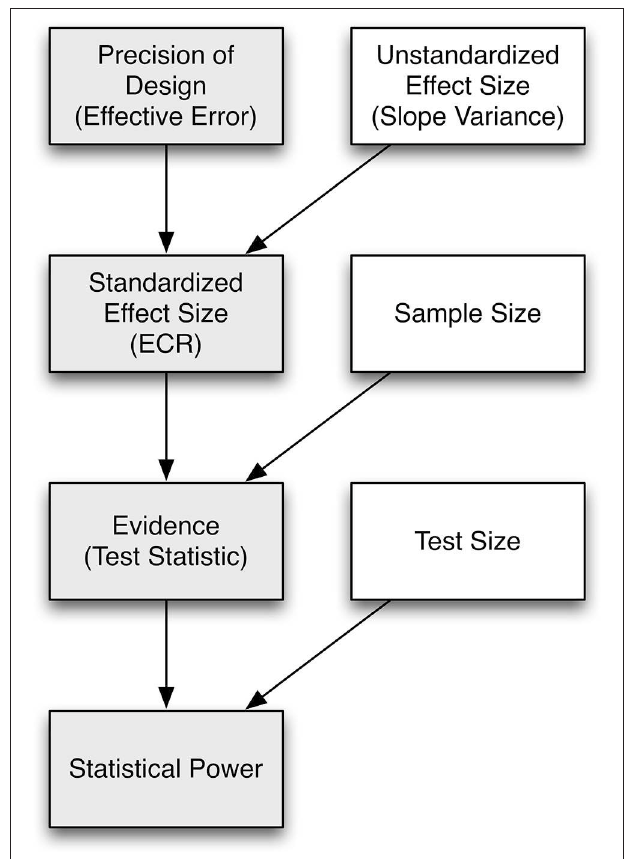
FIGURE 1 | The relation of effective error (as the inverse of precision of a study design), reliability, standardized effect size, evidence, and statistical power is shown as a dependency graph. Gray boxes indicate measures, and white boxes indicate design factors or population values. Each measure conveys change sensitivity, with the number of assumptions to be made about design factors and population values increasing from top to